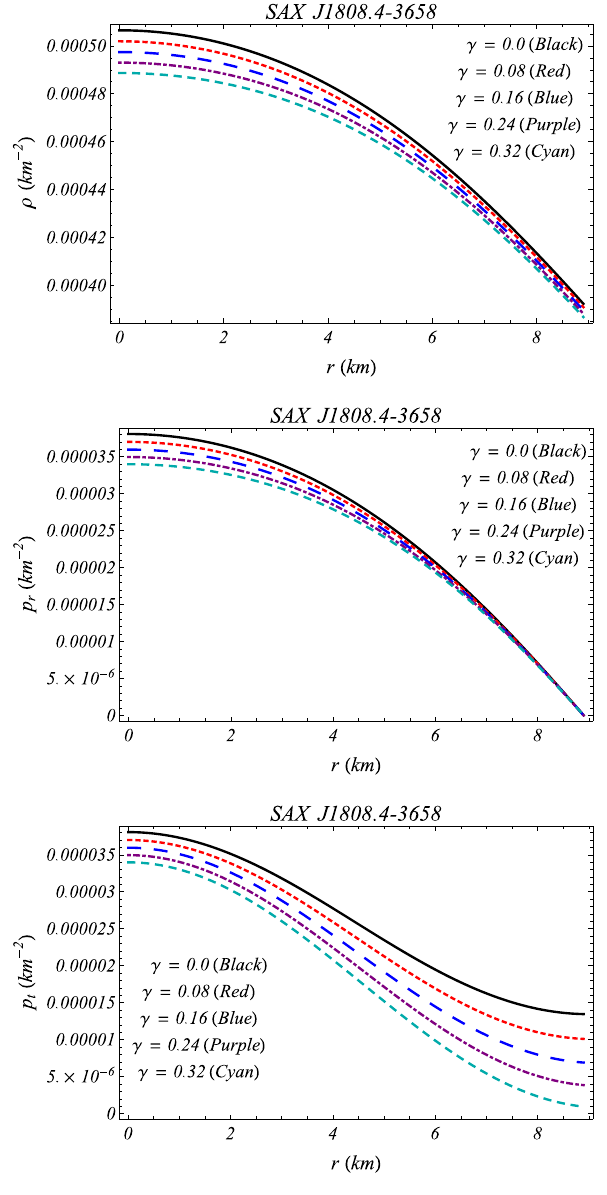
Fig. 2 (Top) Matter density ρ , (middle) radial pressure p r , (bottom) transverse pressure p t against r inside the stellar interior for different values of γ mentioned in the